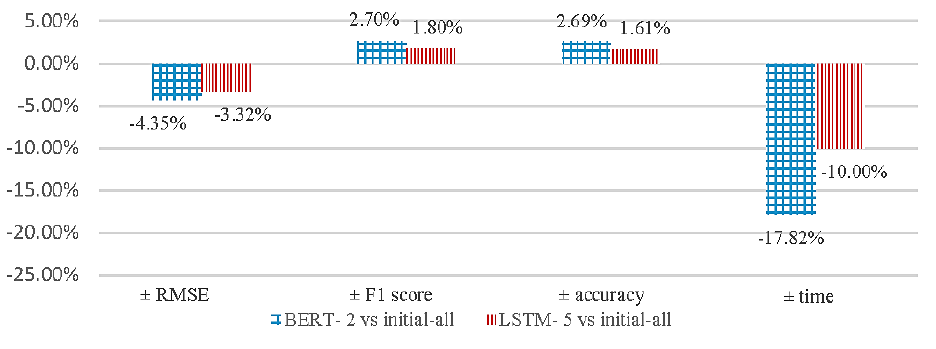
Figure 13. Percent variations averages experienced by the four models, per indicator, and for every quality inspector with Movies and TV data.